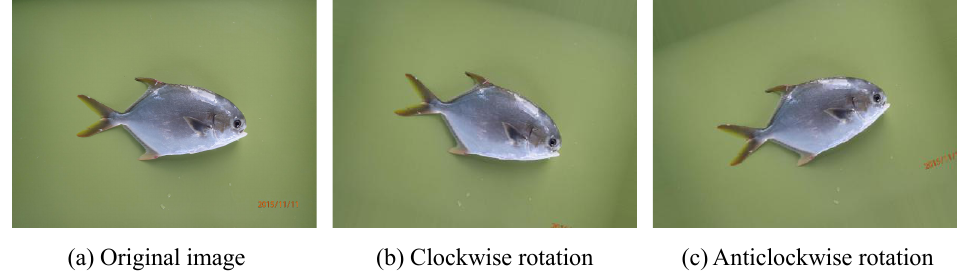
Fig. 4. Effect of the rotation transformation. Figure 5. Data augmentation by rotation